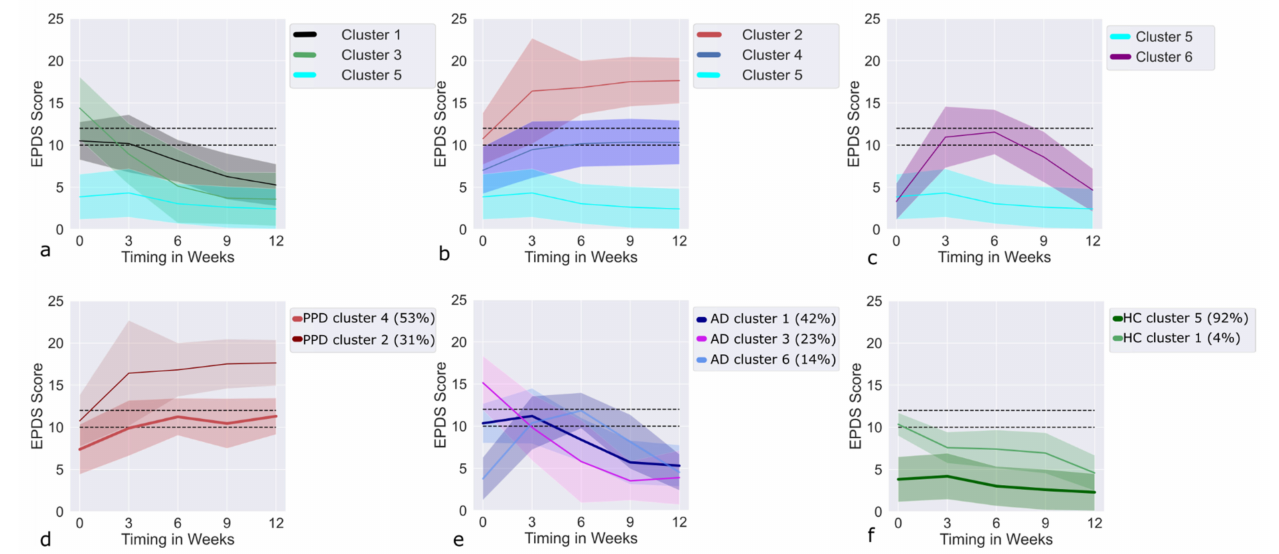
Figure 1. Trajectories of EPDS clusters acquired from the LCMM evaluation. Average value of the EPDS score for each cluster is shown by a solid line, shaded area represents standard deviation around the average. ( a ) Trajectories of the recovering clusters (clusters 1,3) and baseline cluster (cyan, cluster 5); ( b ) Trajectories of the deteriorating clusters (clusters 2,4) and baseline cluster (cyan, cluster 5); ( c ) Trajectories of the delayed-onset recovery cluster (clusters 6) and baseline cluster (cyan, cluster 5); ( d – f ) trajectories of PPD ( d ), AD ( e ) and HC ( f ) diagnoses separately. Percentages next to clusters show the percentage of the cluster in each diagnosis. Abbreviations: EPDS, Edinburgh Postnatal Depression Scale; LCMM, latent class mixed model; PPD, postpartum depression; AD, adjustment disorder; HC, healthy